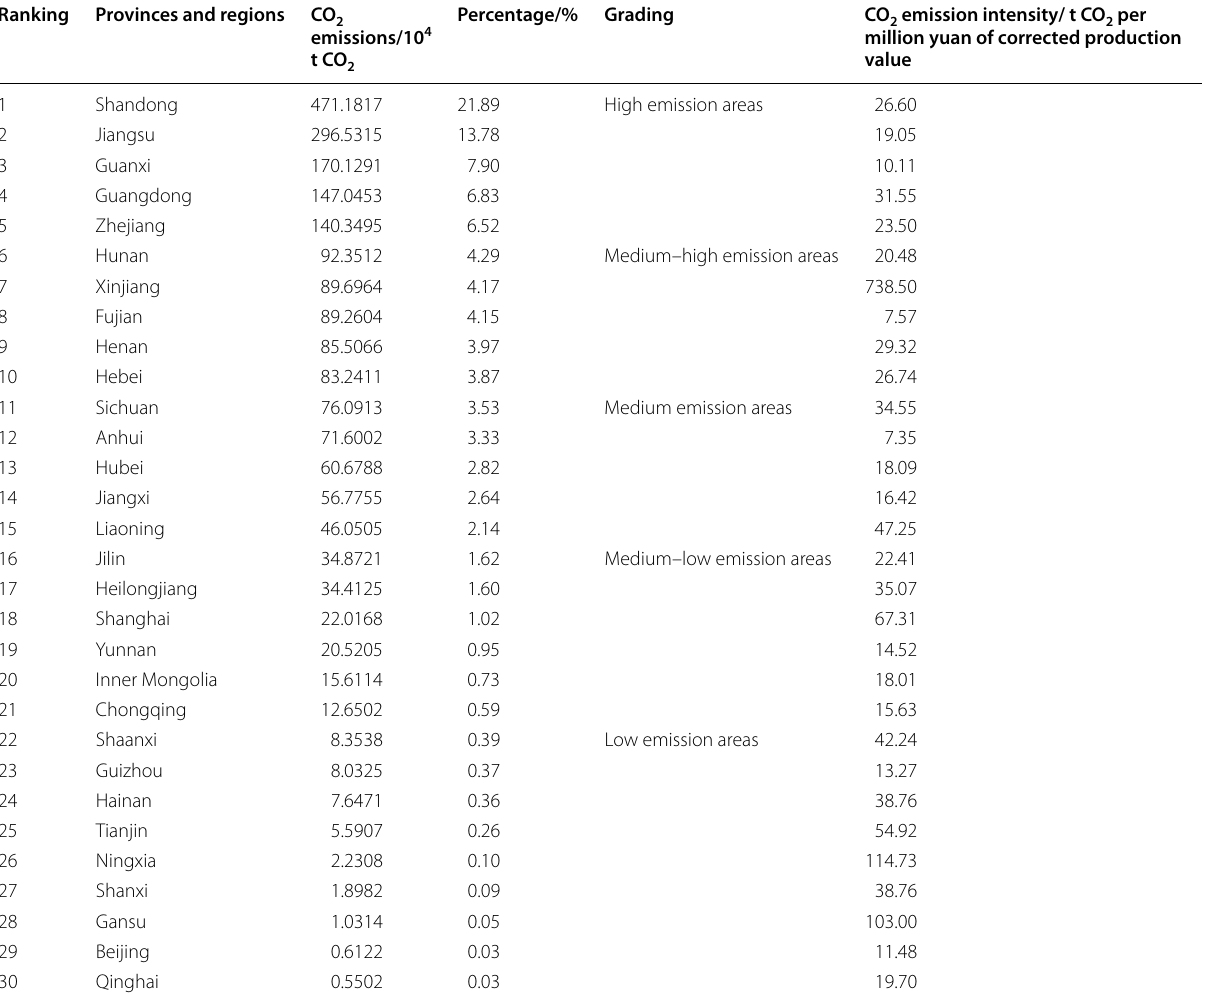
Table 3 CO emissions of the wood and bamboo processing industry of Chinese provinces and regions in 2019 2 Ranking Provinces and